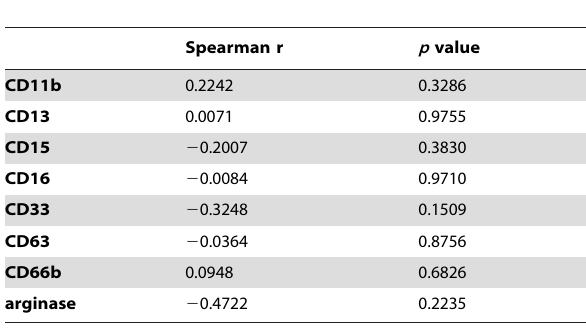
NDGs were isolated from the blood of HIV + patients with CD4 + T cell counts . 350 cells/ m L (n=11) or , 350 cells/ m L (n=10) as described in materials and methods and thes correlation between viral load and phenotypic markers were determined by a Spearman’s rank test.